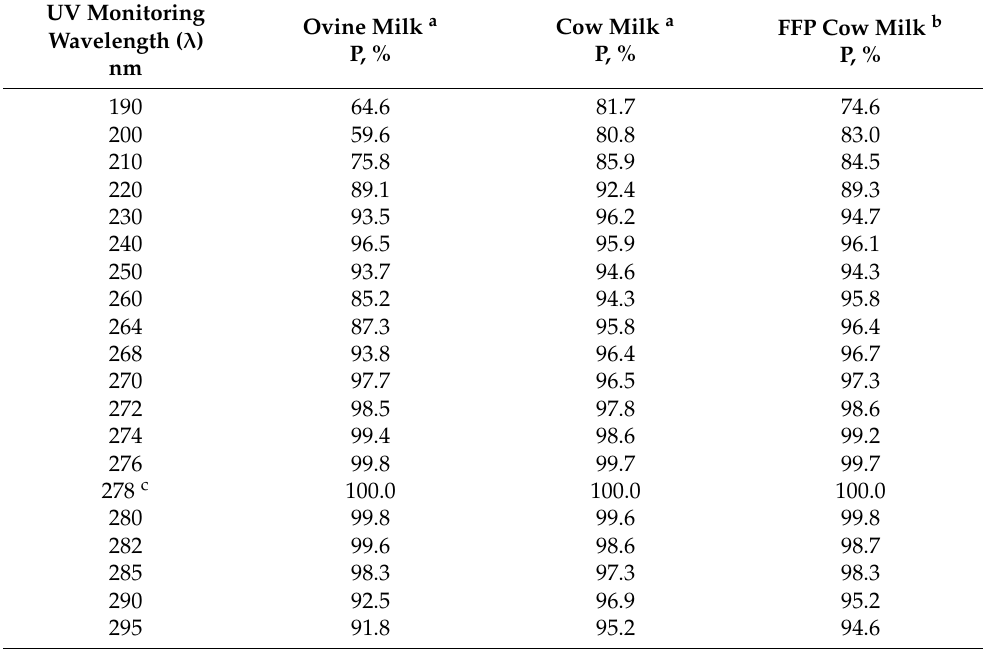
Table 2. Purity (P, %) of the OAc peaks in milk of sheep and cows for particular OAc-monitoring wavelengths ( λ , nm). The injection volume of processed milk samples: 6 µ